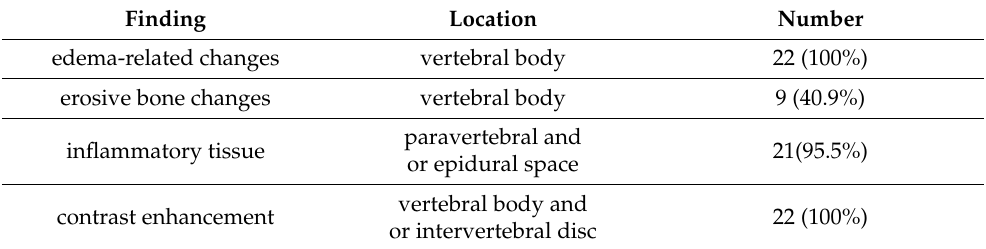
Table 3. Diagnostic findings of spondylodiscitis on MRI in 22 segments (19 patients). Finding